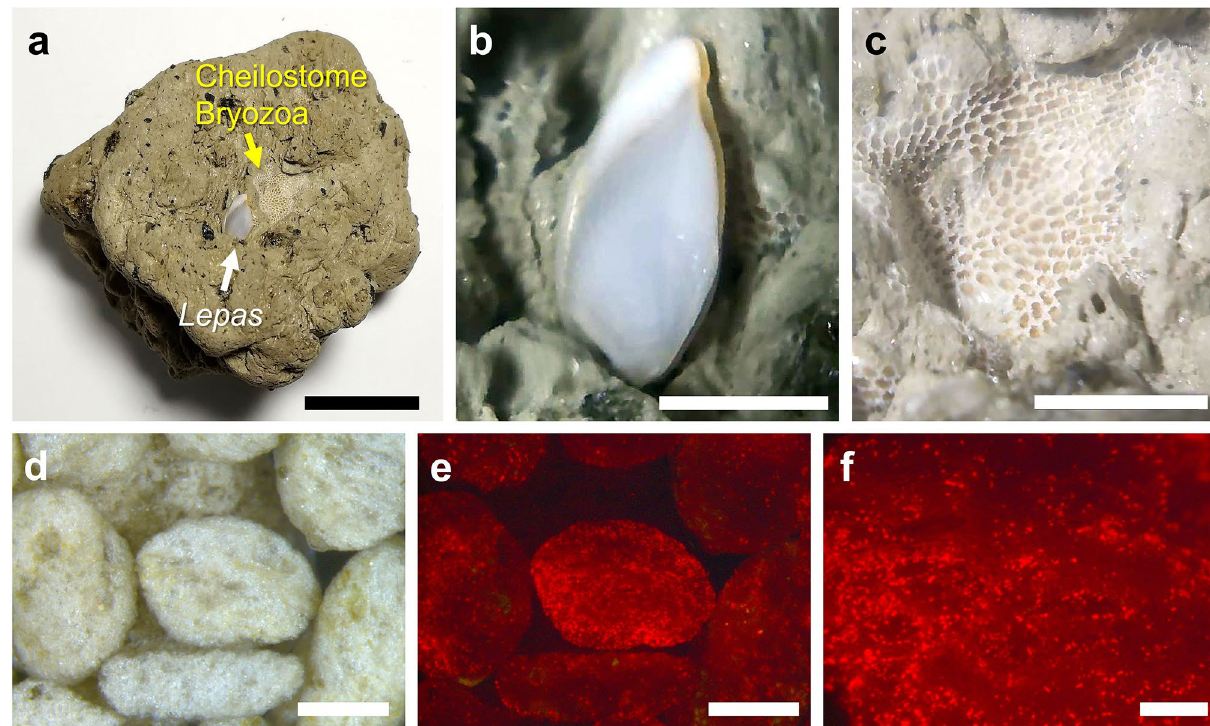
Figure 4. Pumice stones settled by marine organisms. ( a ) Pumice collected from Ibu beach on 31 October 2021. Two marine benthos coexist close together on a pumice stone. Scale bar: 1 cm. ( b ) Enlarged image of the Lepas barnacle. Scale bar: 3 mm. ( c ) Enlarged image of the bryozoan. Scale bar: 3 mm. ( d ) Stereo microscopic image of pumice pebbles of a few millimeters in diameter collected from Ibu beach on 15 January 2022. The light brown coloration indicates some algal/cyanobacterial growth on the pumice. Scale bar 1 mm. ( e ) Red autofluorescence was detected from pumice pebbles. Image corresponds to (d). Autofluorescence from microalgae was confirmed by Supplementary Fig. 2. Scale bar 1 mm. ( f ) Enlarged image of the center of the figure of (e) shows red autofluorescent signals with a diameter of 10–30 µm. Scale bar: 200